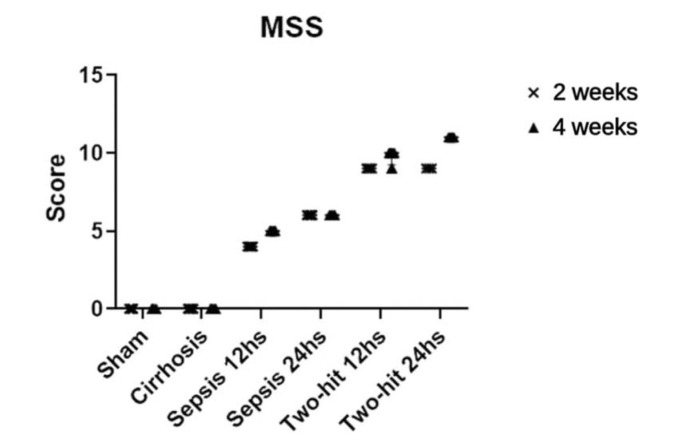
Median score values of MSS (**p<0.01, ***p<0.001, ****p<0.0001 for comparisons with the sham group.